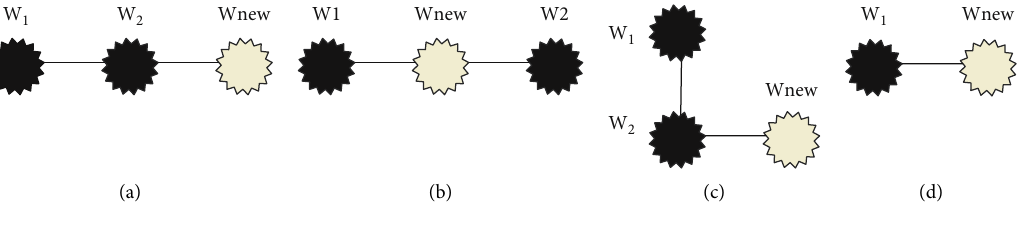
Figure 2: Initialization of the weights of newly generated